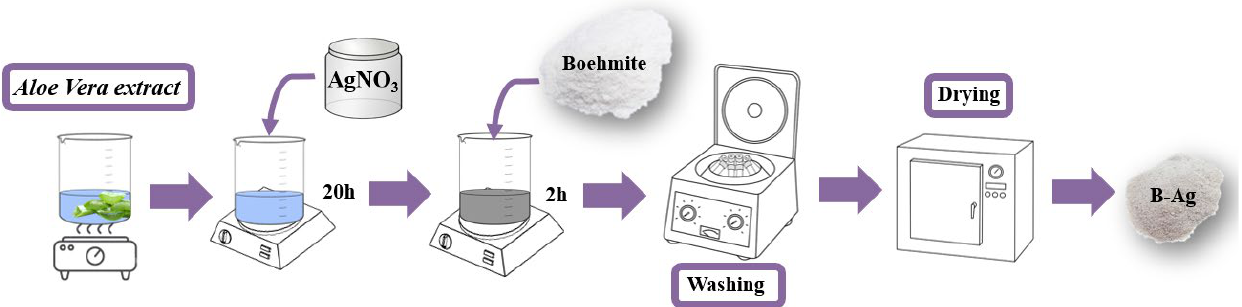
Figure 2. Schematic diagram of the synthesis route used to obtain Ag-boehmite (Ag- (γ -AlO(OH))).